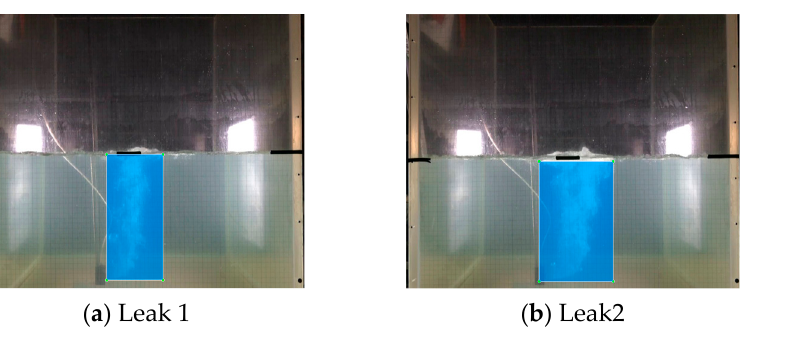
Figure 6. Annotation labels and ground truth boxes for underwater gas plumes under three leakage pressures.